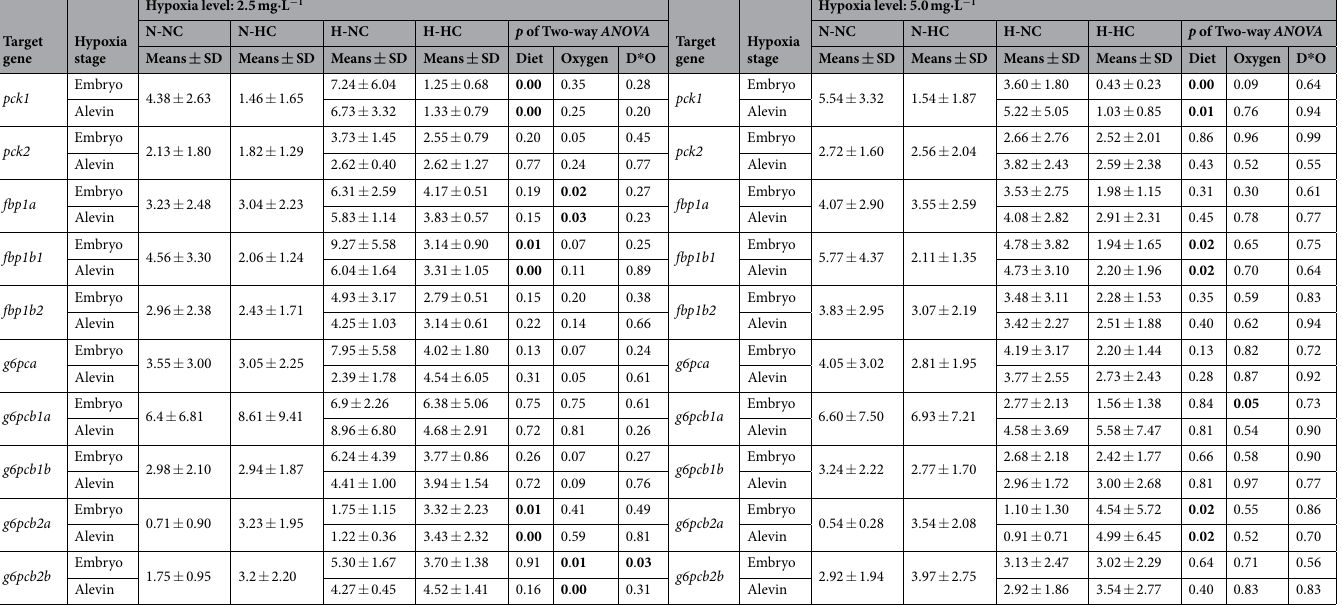
Table 4. Effects of early hypoxia and high-carbohydrate diet at first-feeding on gene expressions involved in gluconeogenesis pathway. N-NC, N-HC, H-NC and H-HC stands for fish subjected to normoxia and no carbohydrate diet, normoxia and high carbohydrate diet, hypoxia and no carbohydrate diet and hypoxia and high carbohydrate diet, respectively. Data were presented as mean ± SD (n = 6), statistical differences were evaluated by two-way ANOVA ( p < 0.05, values in bold).